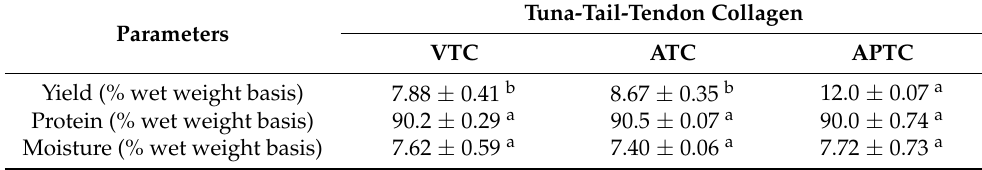
Table 2. The yield, proximate compositions and color of tuna-tail tendon collagen from different three extraction